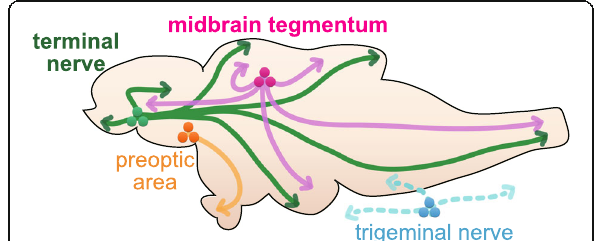
Fig. 1 Schematic illustration of both hypophysiotropic and non- hypophysiotropic GnRH neurons in a teleost brain. Hypophysiotropic neurons: Orange, GnRH neurons in the preoptic area. Non- hypophysiotropic neurons: Green, GnRH neurons in the terminal nerve, Pink, GnRH neurons in the midbrain tegmentum, Blue, GnRH neurons in the trigeminal nerve. Solid lines schematically illustrate axons or dendrites of GnRH neurons in each brain region, and dotted lines show likely